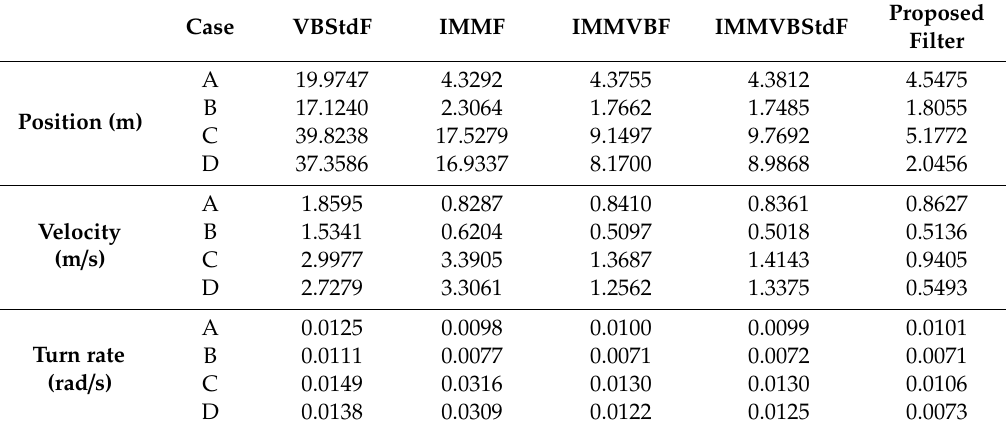
Table 1. Average root mean square errors of filters in four